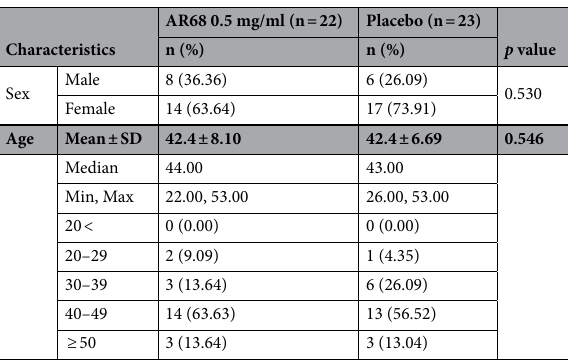
Table 1. Demographic characteristics of the subjects in clinical study